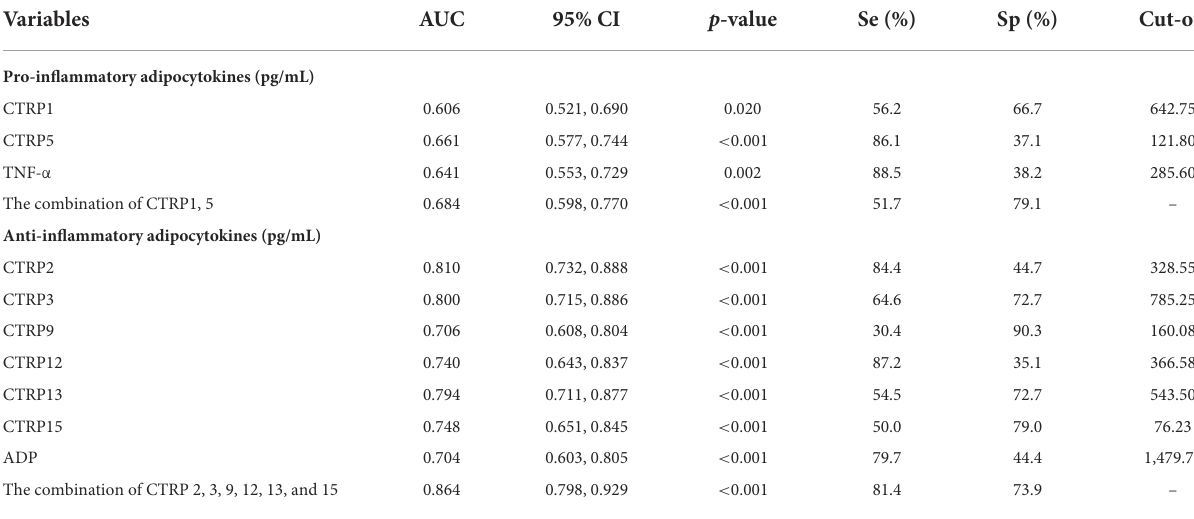
TABLE 2 ROC curve analyses of pro-inflammatory and anti-inflammatory adipocytokines for diagnosing ACS.